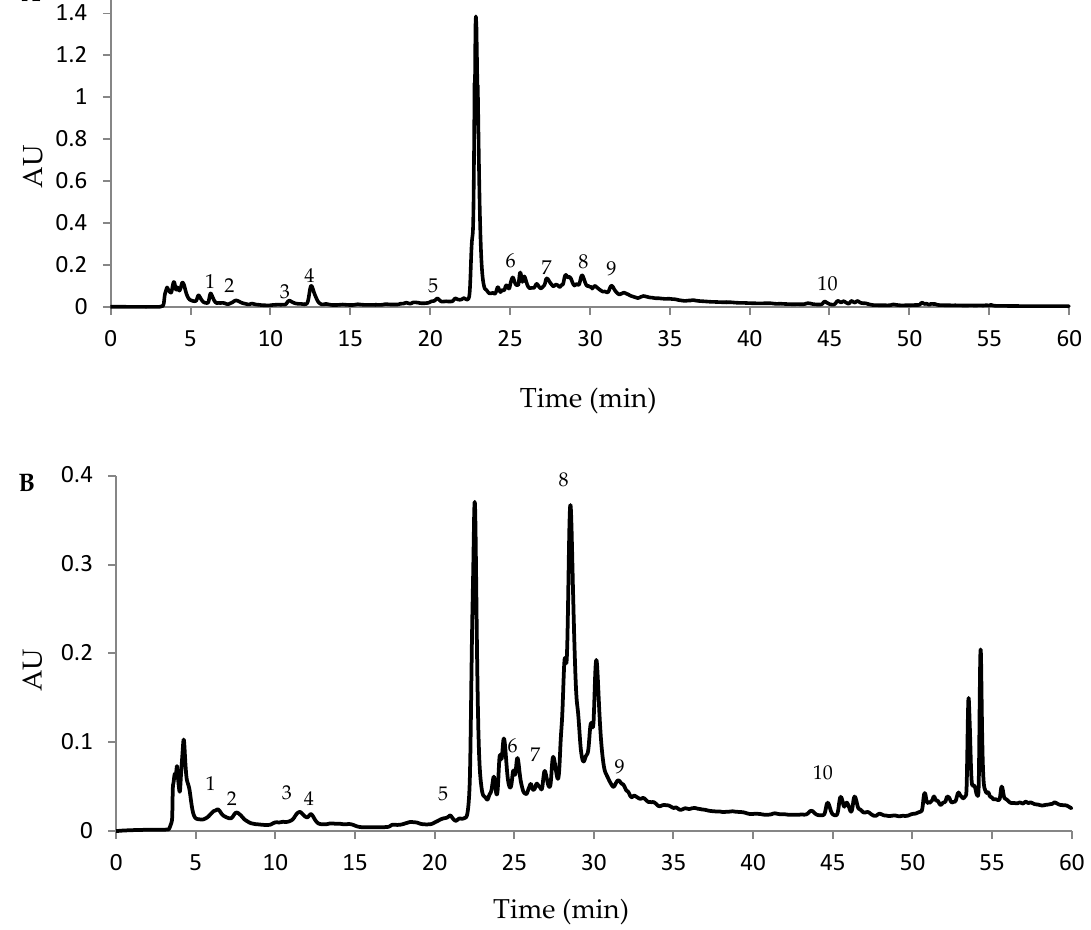
Figure 1. HPLC phenolic profile of ( A ) hydromethanolic and ( B ) water extracts prepared from commercial Morus alba L. (sample 2). The retention times (min) for quantified compounds were as follows: 5.88 (gallic acid, peak 1), 7.25 (ca ff eic acid, peak 2), 10.74 ( p -coumaric acid, peak 3), 11.97 (chlorogenic acid, peak 4), 20.18 (vanillic acid, peak 5), 24.63 (ferulic acid, peak 6), 26.68 (rosmarinic acid, peak 7), 28.74 (rutin, peak 8), 30.90 (quercetin, peak 9) and 44.16 (apigenine, peak